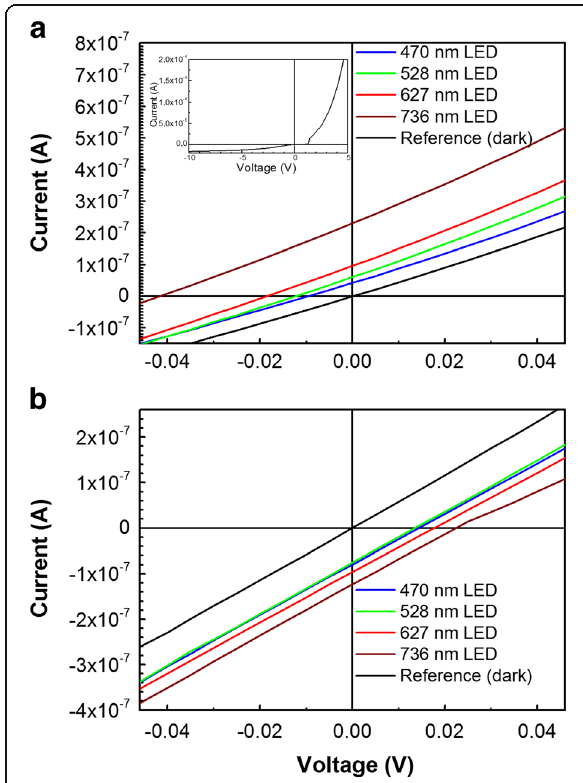
Fig. 5 Typical I-U dependences of DLC:Ag/p-Si ( a ) and DLC:Ag/n-Si ( b ) heterojunctions illuminated with light of different wavelength. In the inset of Fig. 5a, dark I-V dependence of DLC:Ag/p-Si heterojunction in broader voltages range is presented